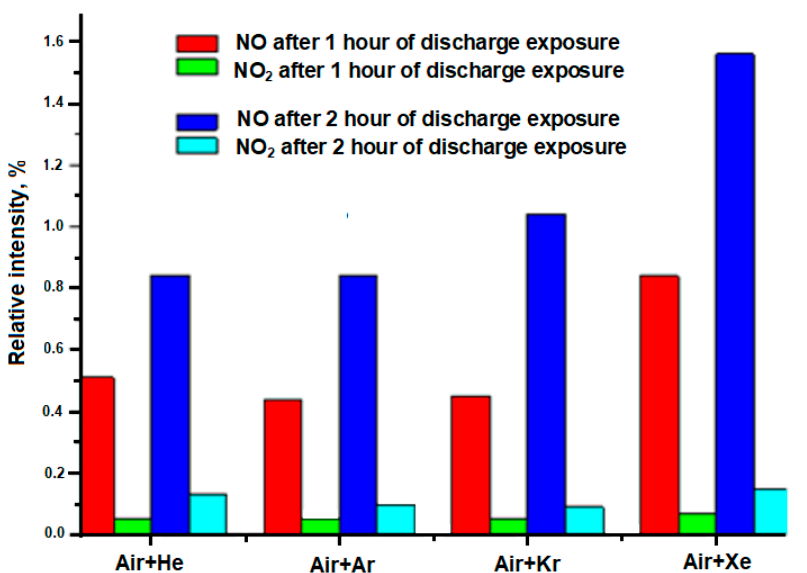
Figure 5. The dependence of the relative intensity of the NO and NO 2 bands after 1 and 2 h of irradiation of the initial mixture.